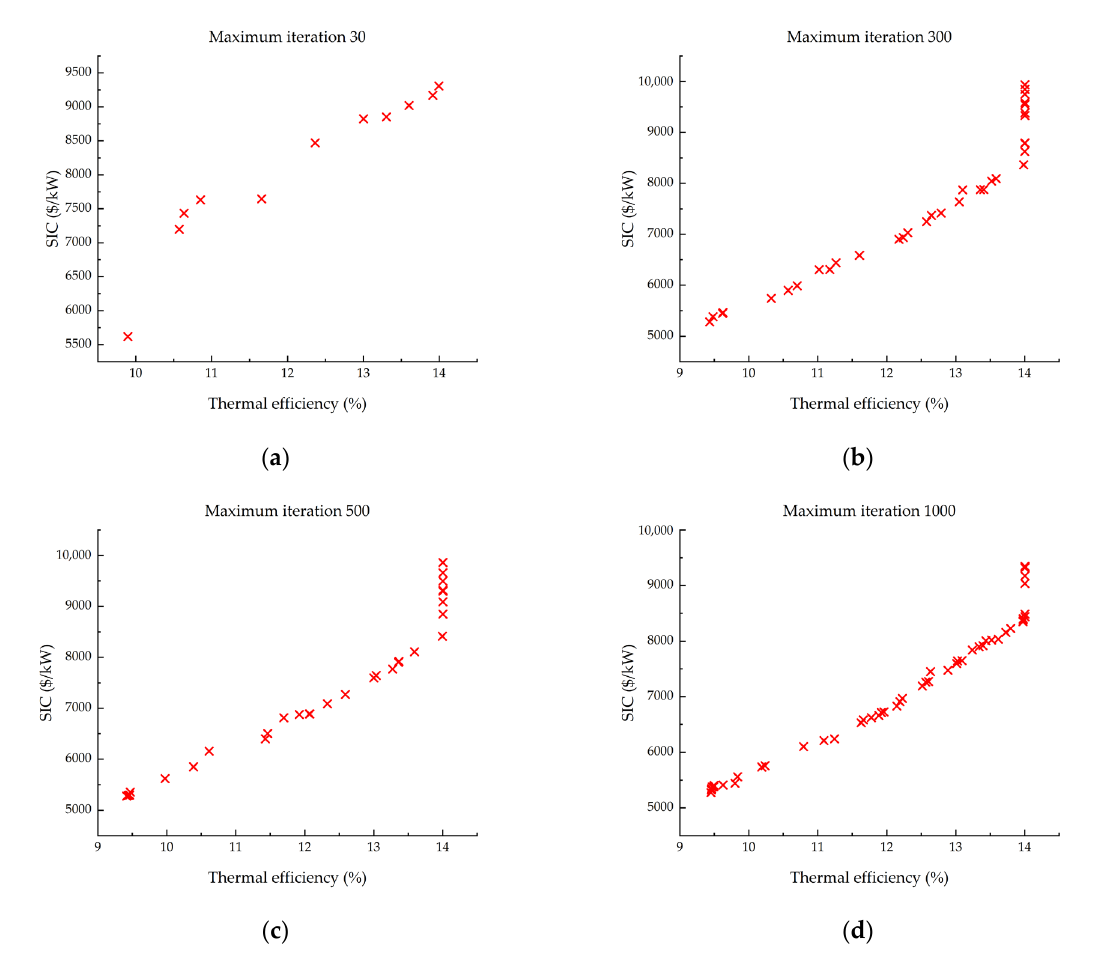
Figure 8. The effect of the maximum number of iterations on the optimization results: ( a – d ) Maximum iteration was 30, 300, 500 and 1000, respectively.